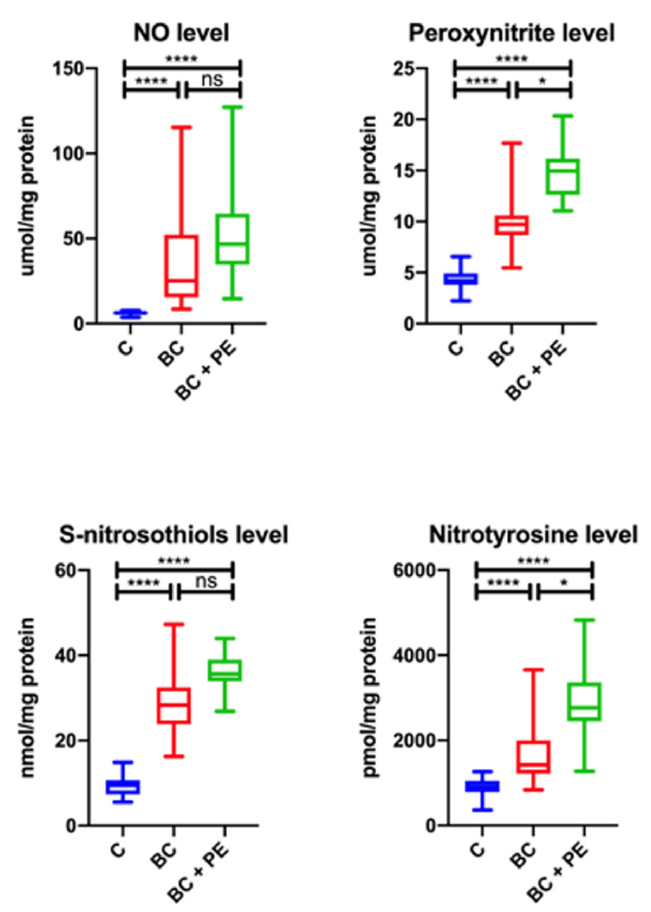
Figure 4. Results for nitrosative stress parameters in the study groups. * p < 0.05, ** p < 0.01, *** p <